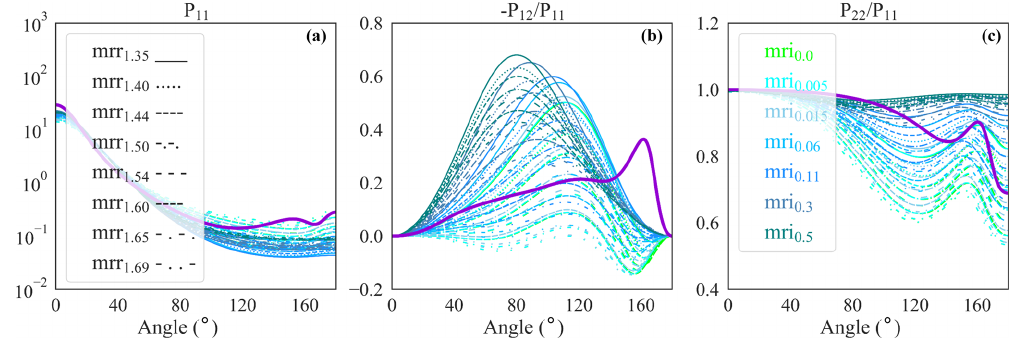
Figure 13. Comparison of the optical properties at λ = 440nm for near-spherical particles (purple line) and the particles considered in the AERONET non-spherical model (blue lines). (a) P 11 (phase function), (b) − P 12 /P 11 (degree of linear polarization), (c) P 22 /P 11 . Purple lines in the plots show calculations considering the near-spherical particle properties derived for the stratospheric smoke particles from the Canadian fires, with mean axial ratio ε s = 1 . 4, monomodal, lognormal size distribution with r g = 0 . 25µm, σ g = 0 . 4 and complex refractive index m = 1 . 55 − i 0 . 03. Blue lines in the plots show calculations using the AERONET non-spherical model, monomodal, lognormal size distributions with r g = 0 . 25µm and refractive indices of mrr = 1 . 35, 1.40, 1.44, 1.50, 1.54, 1.60, 1.65 and 1.69 for the real part (different line styles in the plot) and mri = 0 . 0, 0.005, 0.015, 0.06, 0.11, 0.3 and 0.5 for the imaginary part (different line colours in the plot).